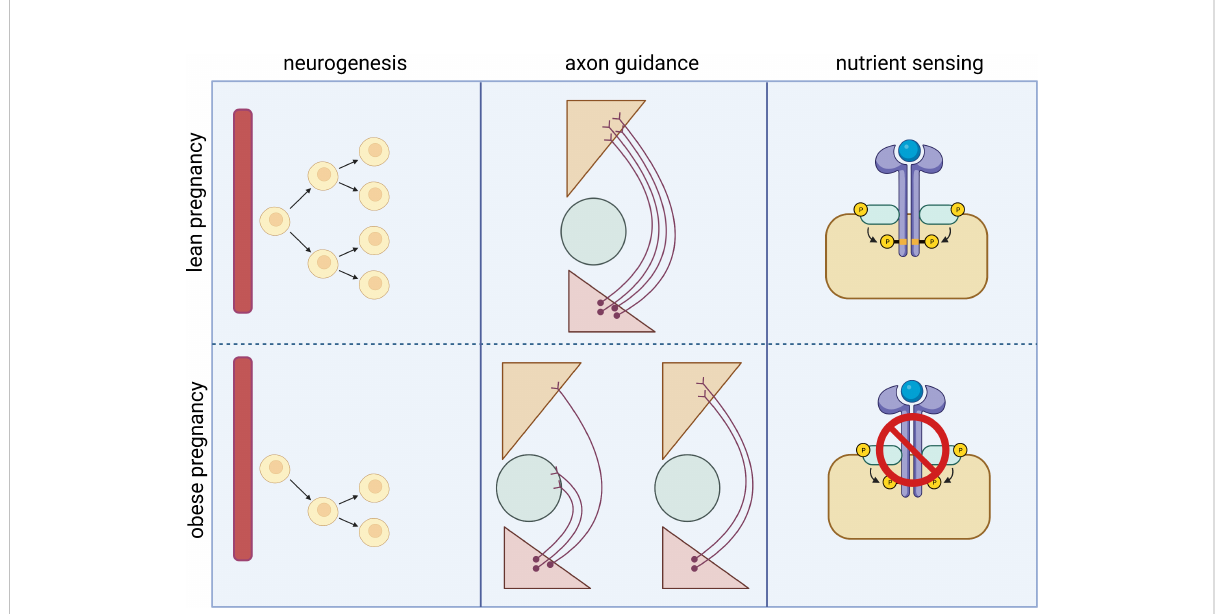
FIGURE 2 Heat map depicting changes in hormone/nutrient levels across the course of pregnancy in lean and obese mothers. The change in circulating levels of metabolic hormones and nutrients such as glucose and lipids throughout the course of a normal, lean pregnancy are shown in the left panel. Many of these factors are altered in women living with obesity and are thus altered also in pregnancies complicated by obesity with GDM as depicted in the right